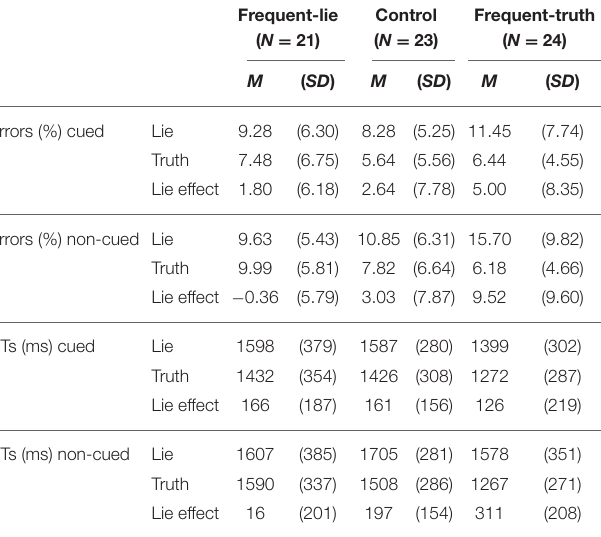
TABLE 2 | Errors and reaction times on cued and non-cued trials in Experiment 2. Frequent-lie Control